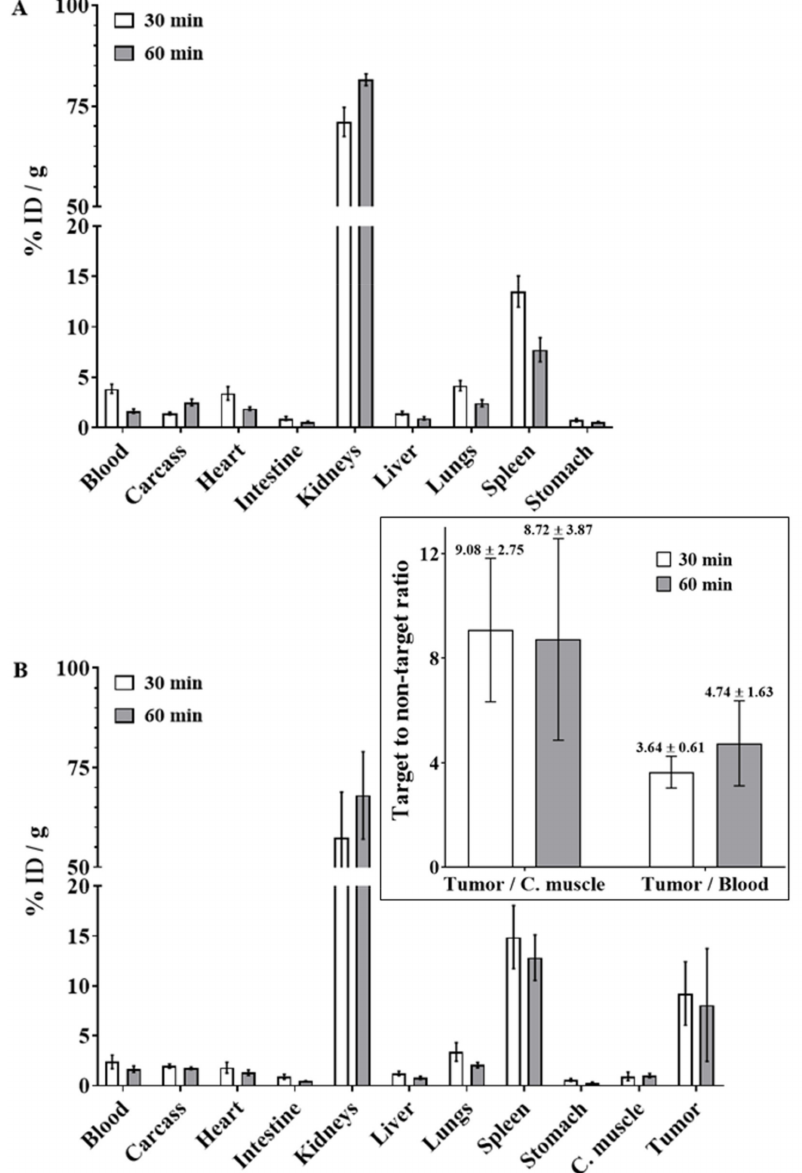
Figure 4. Ex vivo biodistribution profile obtained at 30 and 60 min after intravenous injection of [ 68 Ga]Ga-PSMA-11 into ( A ) healthy and ( B ) LNCaP-tumor-bearing mice. Insert: Target-to-non-target ratios calculated with ex vivo biodistribution data obtained in LNCaP-tumor-bearing mice. The values are expressed as “mean ± SD” (n = 5). C. muscle: contralateral